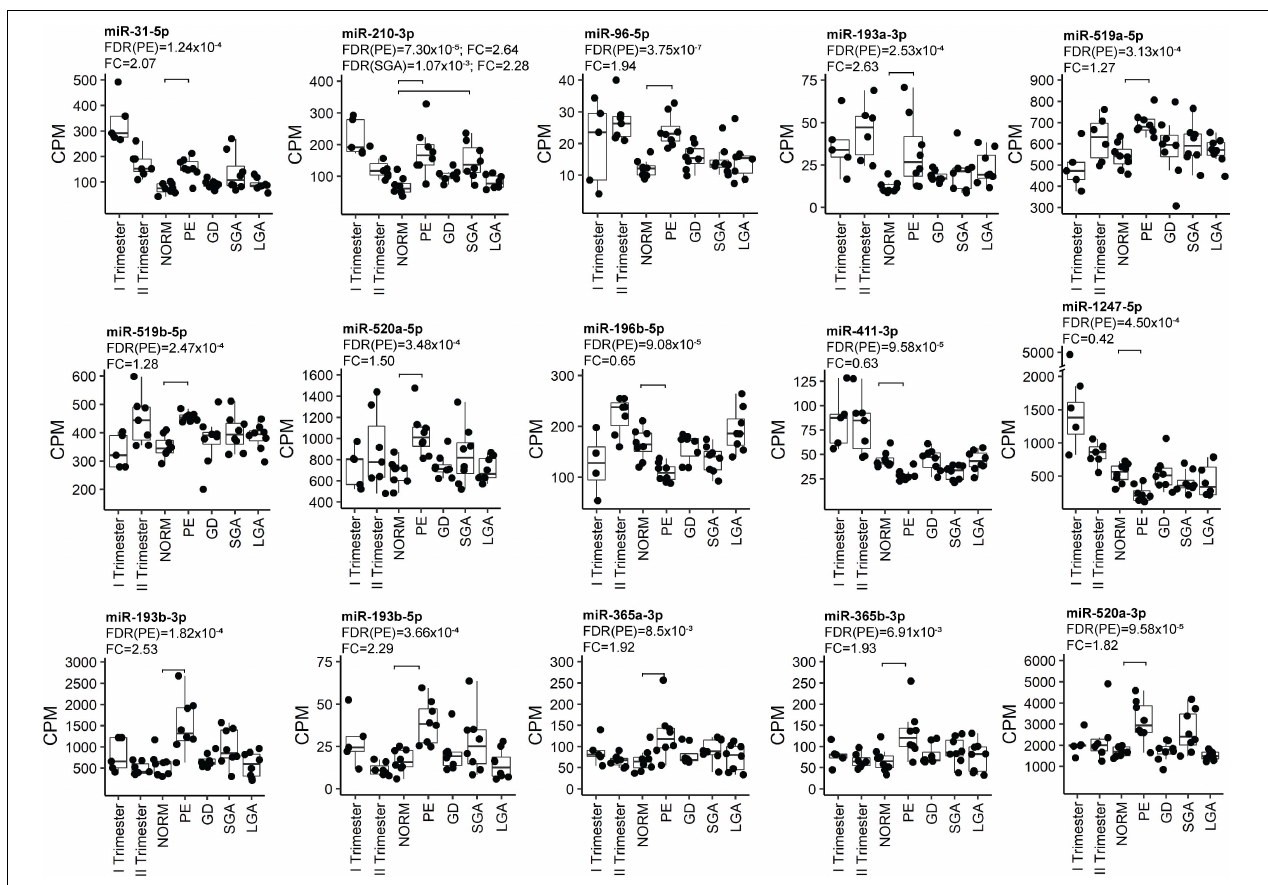
FIGURE 4 | Examples of the most significant differentially expressed miRNAs in PE. miRNA expression was quantified in counts per million mapped reads (CPM). FDR, false discovery rate, calculated based on Benjamini–Hochberg method; GD, gestational diabetes; NORM, normal term pregnancy; PE, preeclampsia; LGA, large-for-gestational-age; FC, fold change in CPM; SGA, small-for-gestational-age.